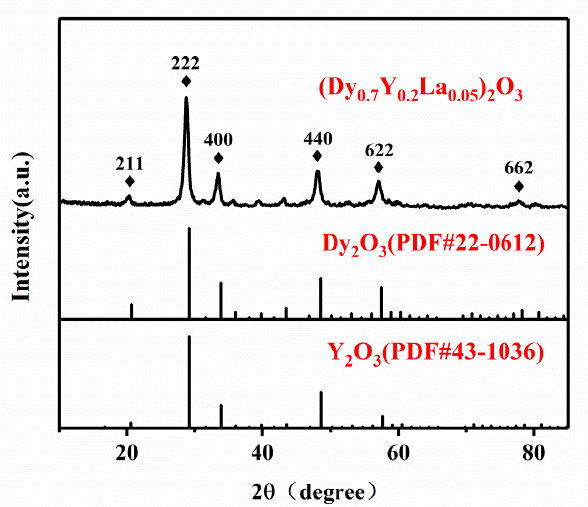
Figure 1. X-ray diffraction pattern of (Dy 0.7 Y 0.25 La 0.05 ) 2 O 3 powder. Figure 1. X-ray di ff raction pattern of (Dy 0.7 Y 0.25 La 0.05 ) 2 O 3